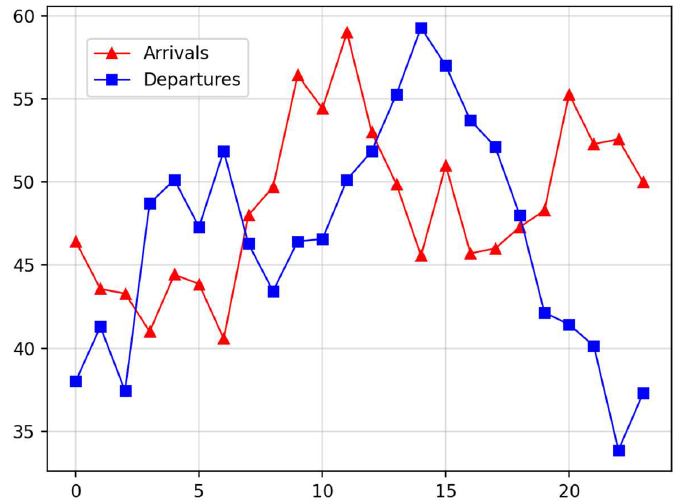
Figure 9. The line chart of the ship arrivals and departures at Shanghai Port for one day.